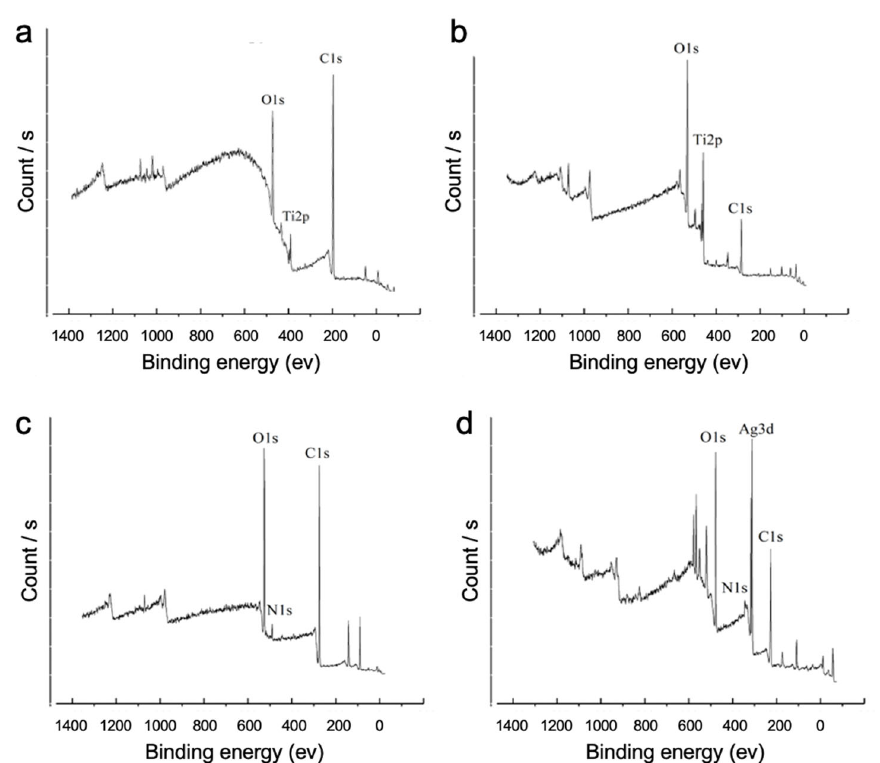
Materials 2021 , 14 , x FOR PEER REVIEW Figure 4. XPS spectra of ( a ) original titanium alloy (Ti), ( b ) Ti ‐ OH, ( c ) Ti ‐ gel, and ( d ) Ti ‐ gel ‐ AgNPs. Figure 4. XPS spectra of ( a ) original titanium alloy (Ti), ( b ) Ti-OH, ( c ) Ti-gel, and ( d ) Ti-gel-AgNPs.